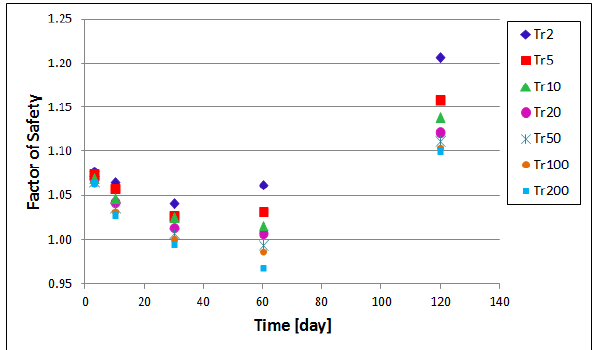
Fig. 14. Variation of factor of safety for rainfall cumulated from 3 to 120 days with different return